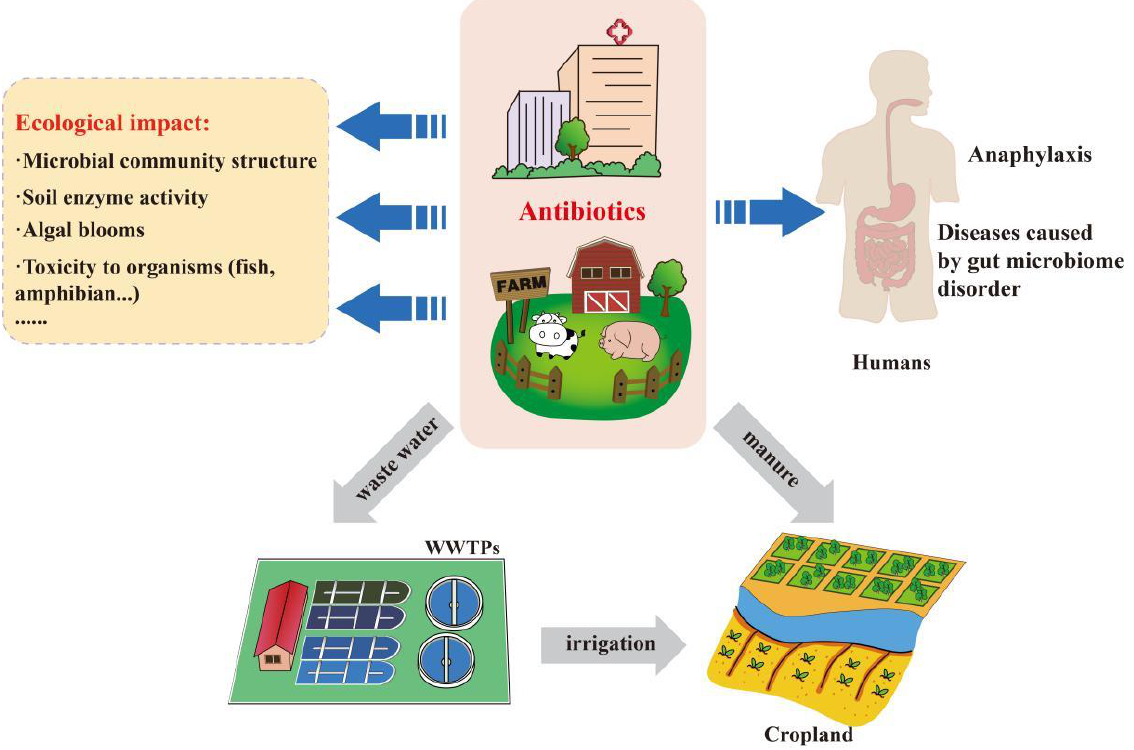
Figure 1. Environmental transmission of antimicrobials and impact on human health and ecology. Antimicrobials are mainly used in hospitals and farms, and some of them are removed by WWTPs, while the rest are spread into the environment. Antimicrobials entered into the environment have adverse effects on ecology and affect human health.